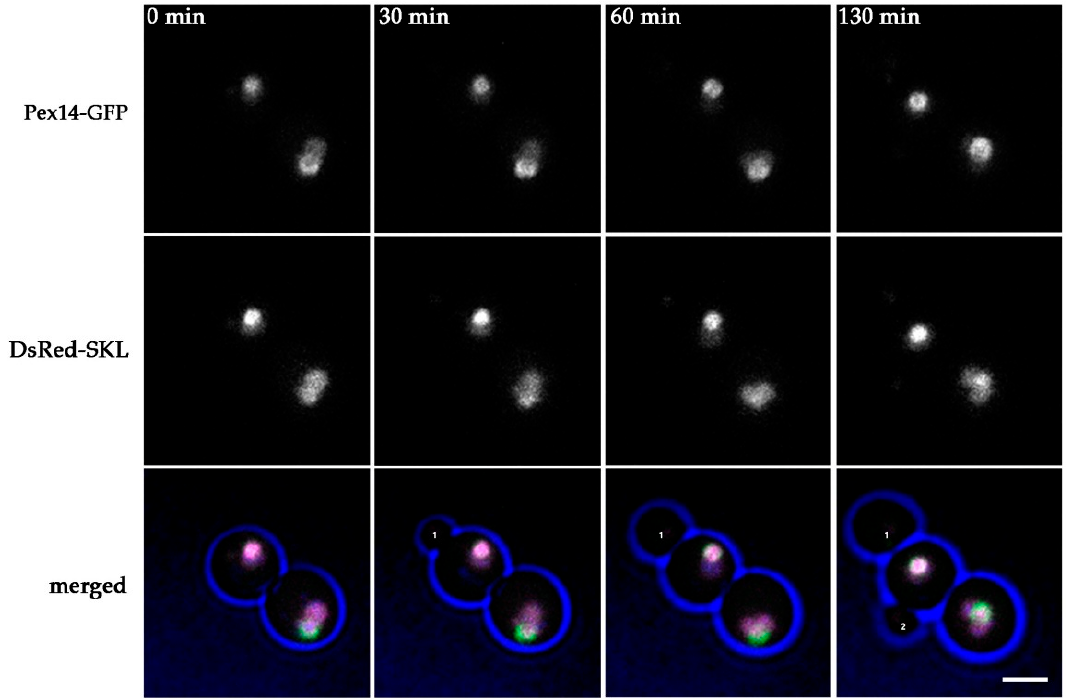
Figure 3. In H. polymorpha pex11 inp2 cells peroxisome inheritance is fully blocked. Stills from a CLSM video (Supplementary Data S2) representing budding pex11 inp2 cells producing Pex14-GFP and DsRed-SKL. Blue represents cell edges. Labels “1” and “2” mark two different daughter cells that did not inherit Pex14-GFP containing structures from the mother cell. Scale bar represents 2 µm.